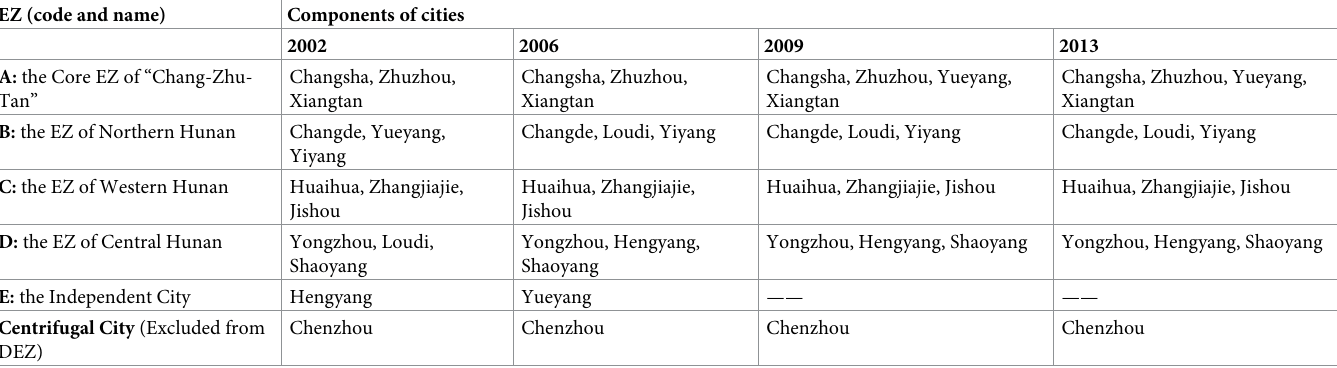
Table 4. The components of cities in each EZ from 2002 to 2013